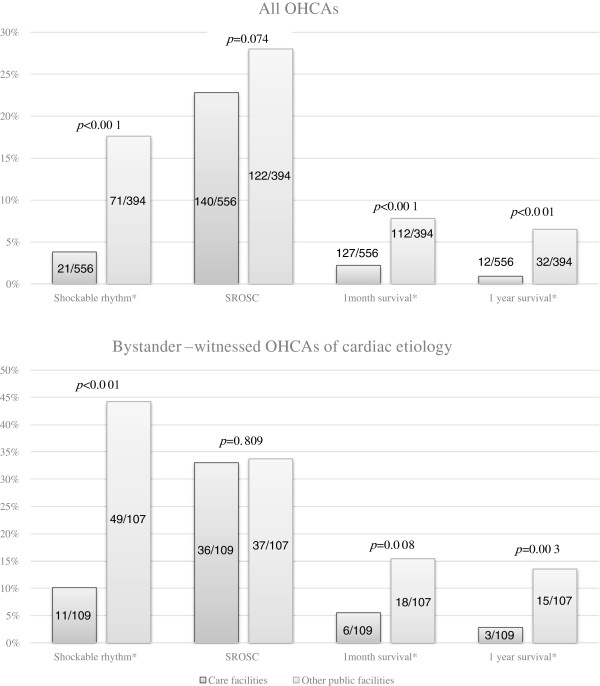
Comparison of the outcome and incidence of VF/VT in relation to location.SROSC sustained return of spontaneous circulation. *Significantly different between care facilities and other public facilities (p < 0.05).